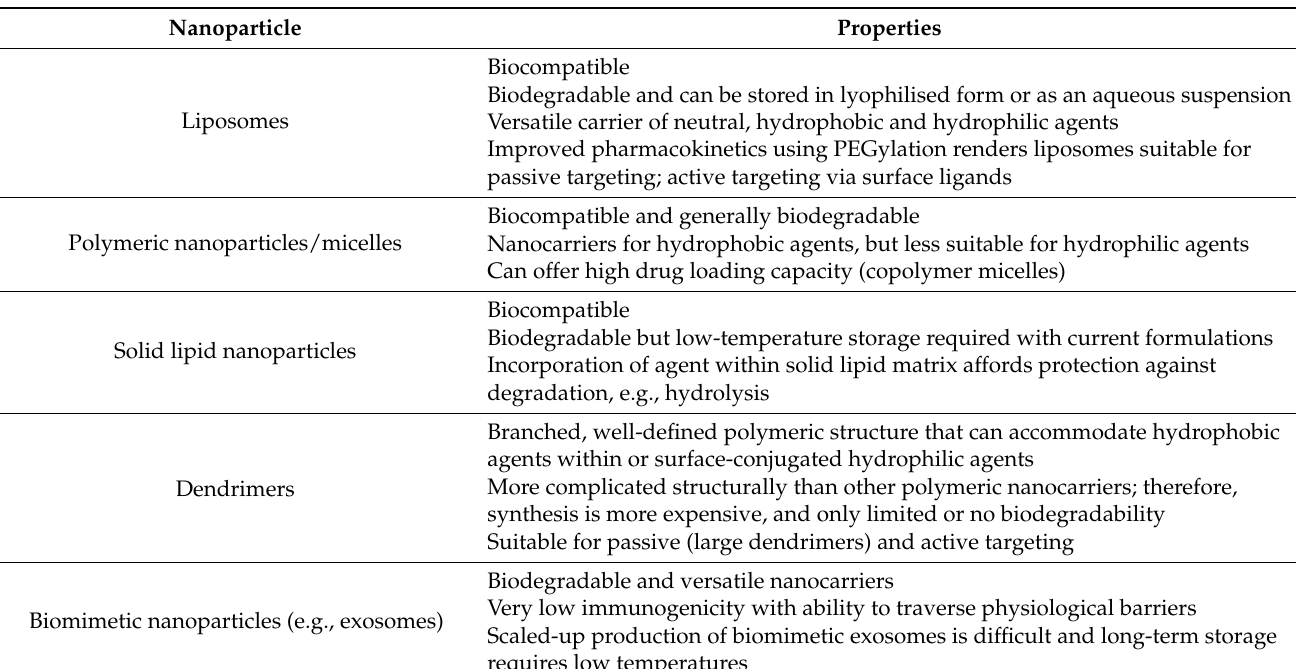
Table 4. Summary of properties of different types of organic